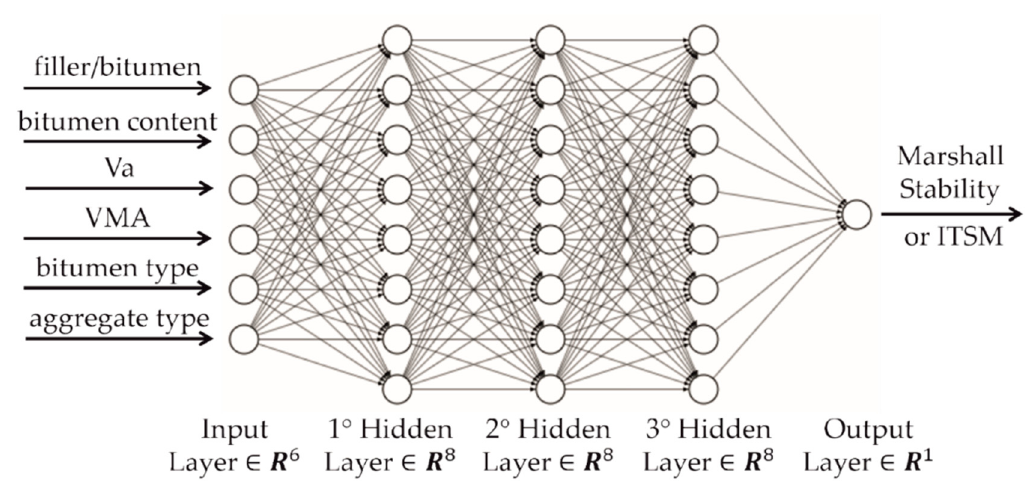
Figure 6. ANN final architecture to predict the Marshall stability or the stiffness modulus.